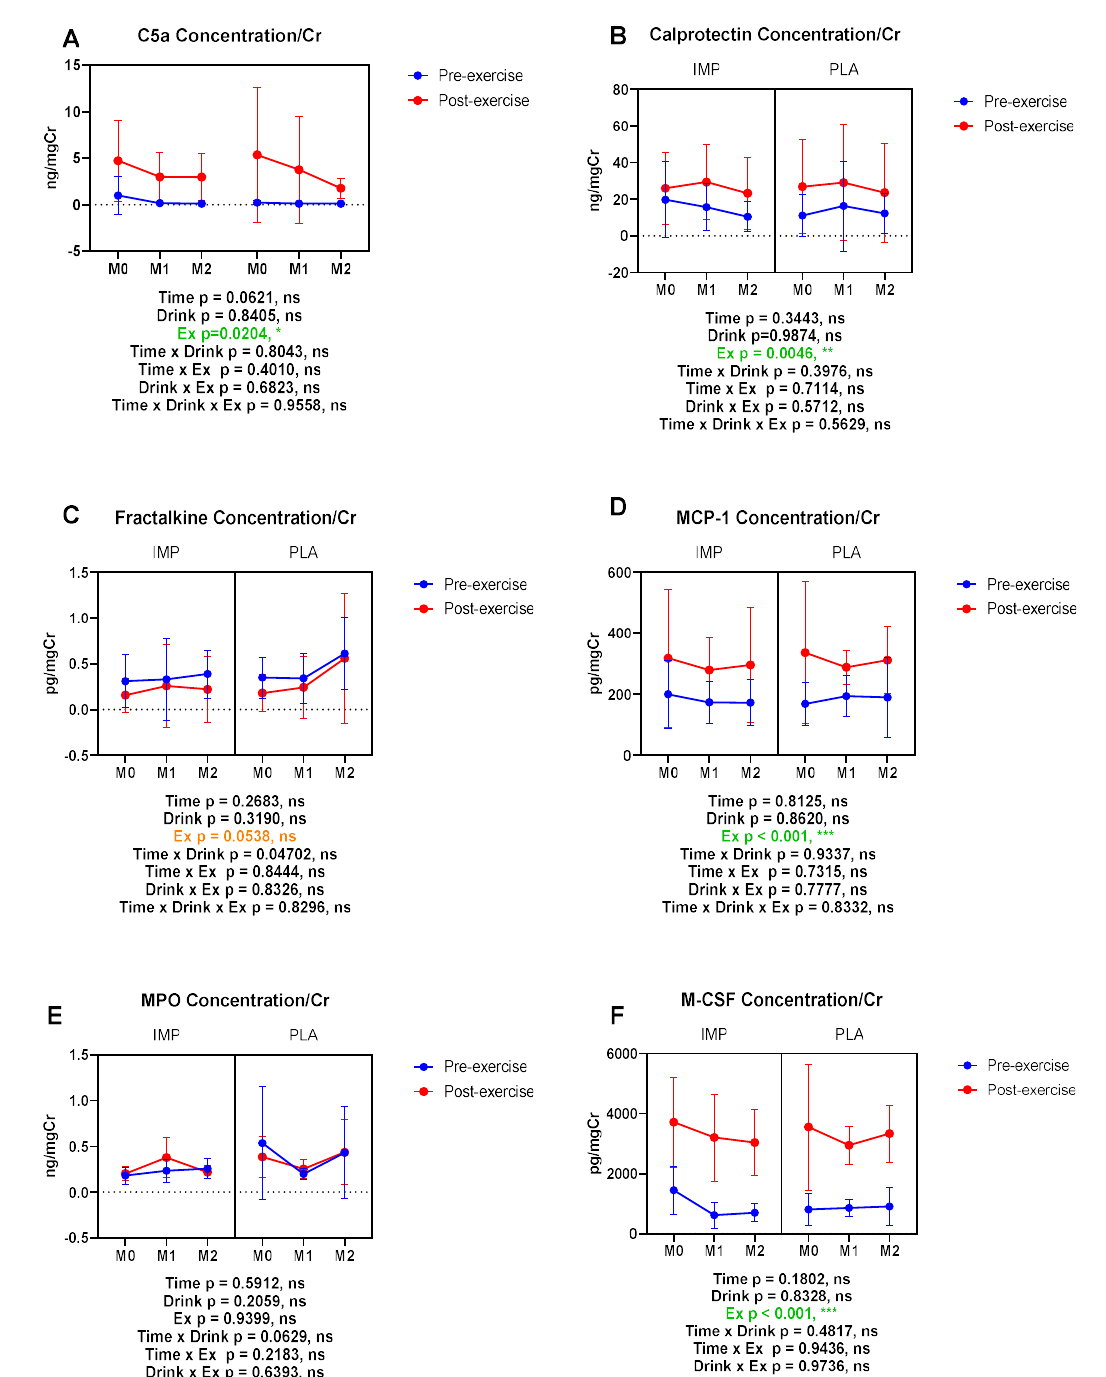
Figure 8. Urine complement 5a (C5a) ( A ), calprotectin ( B ), fractalkine ( C ), monocyte chemotactic protein (MCP)-1 ( D ), myeloperoxidase (MPO) ( E ), and macrophage colony-stimulating factor (M-CSF) ( F ) concentrations corrected with creatinine. The data are presented as means ± SD. * p < 0.05 and *** p < 0.001. Green text indicates a significance < 0.05 and orange text indicates a significance <